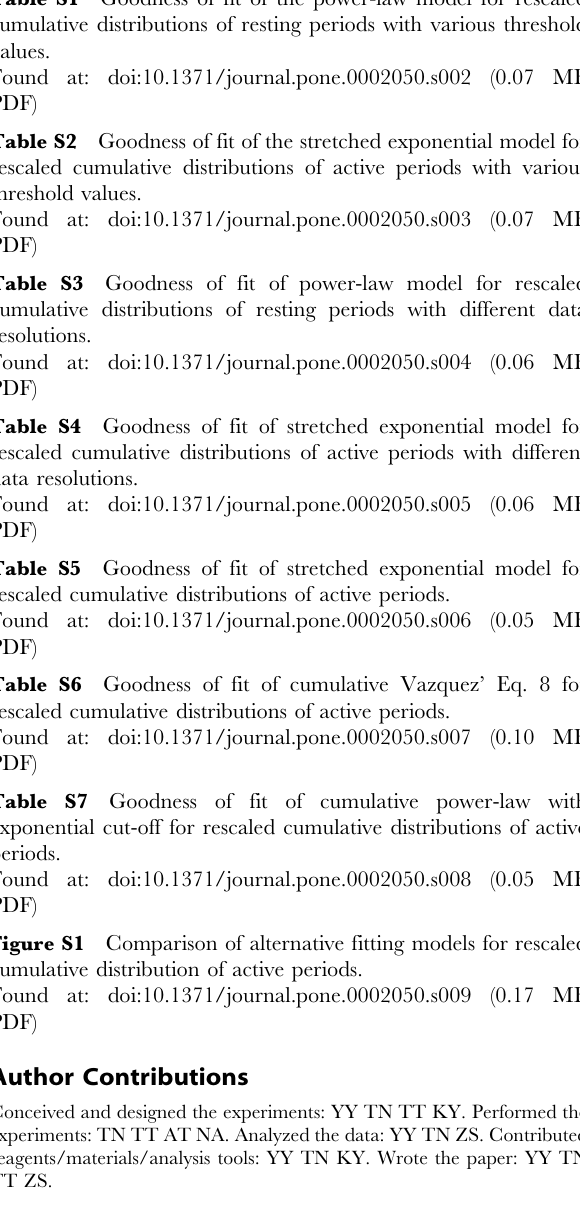
Table S1 Goodness of fit of the power-law model for rescaled cumulative distributions of resting periods with various threshold values.